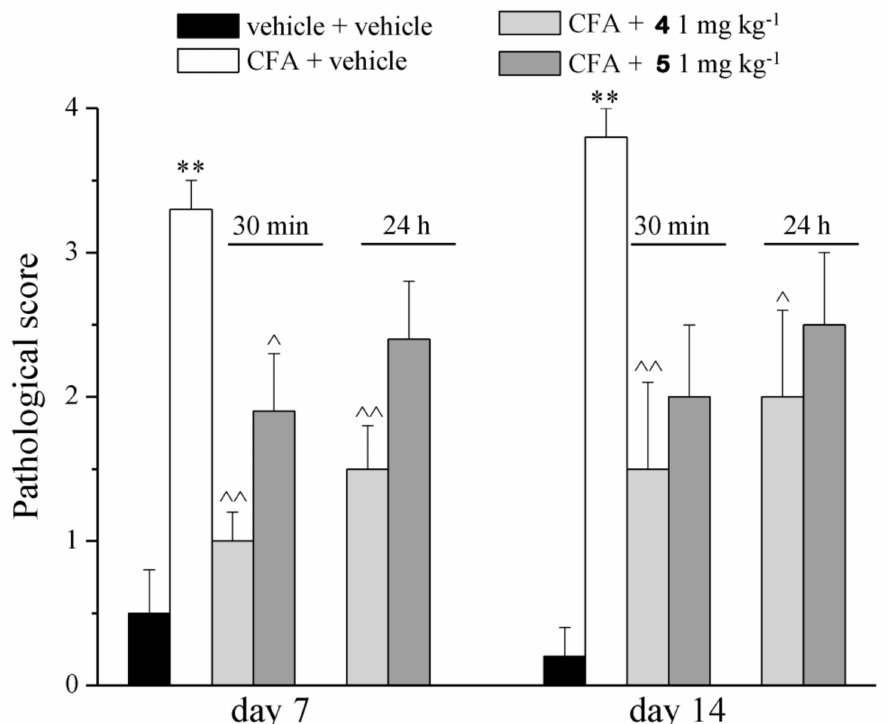
Figure 3. Preventive pain reliever e ff ect of compounds 4 and 5 in a CFA i.a. injection-induced RA model in rats. Beam Balance test was used to assess the motor skills of the animals. Results were reported as behavioural score ranging from 0 (normal animals) to 4 (the higher pathological response). 4 and 5 (both 1 mg kg − 1 ) were suspended in 1% CMC and orally daily administered starting on the day of CFA i.a. injection. Measurements were performed on day 7 and 14. Control animals were treated with vehicle. The value represent the mean of eight rats performed in two di ff erent experimental sets. ** p < 0.01 vs. vehicle + vehicle-treated animals; ˆ p < 0.05 and ˆˆ p < 0.01 vs. CFA + vehicle-treated